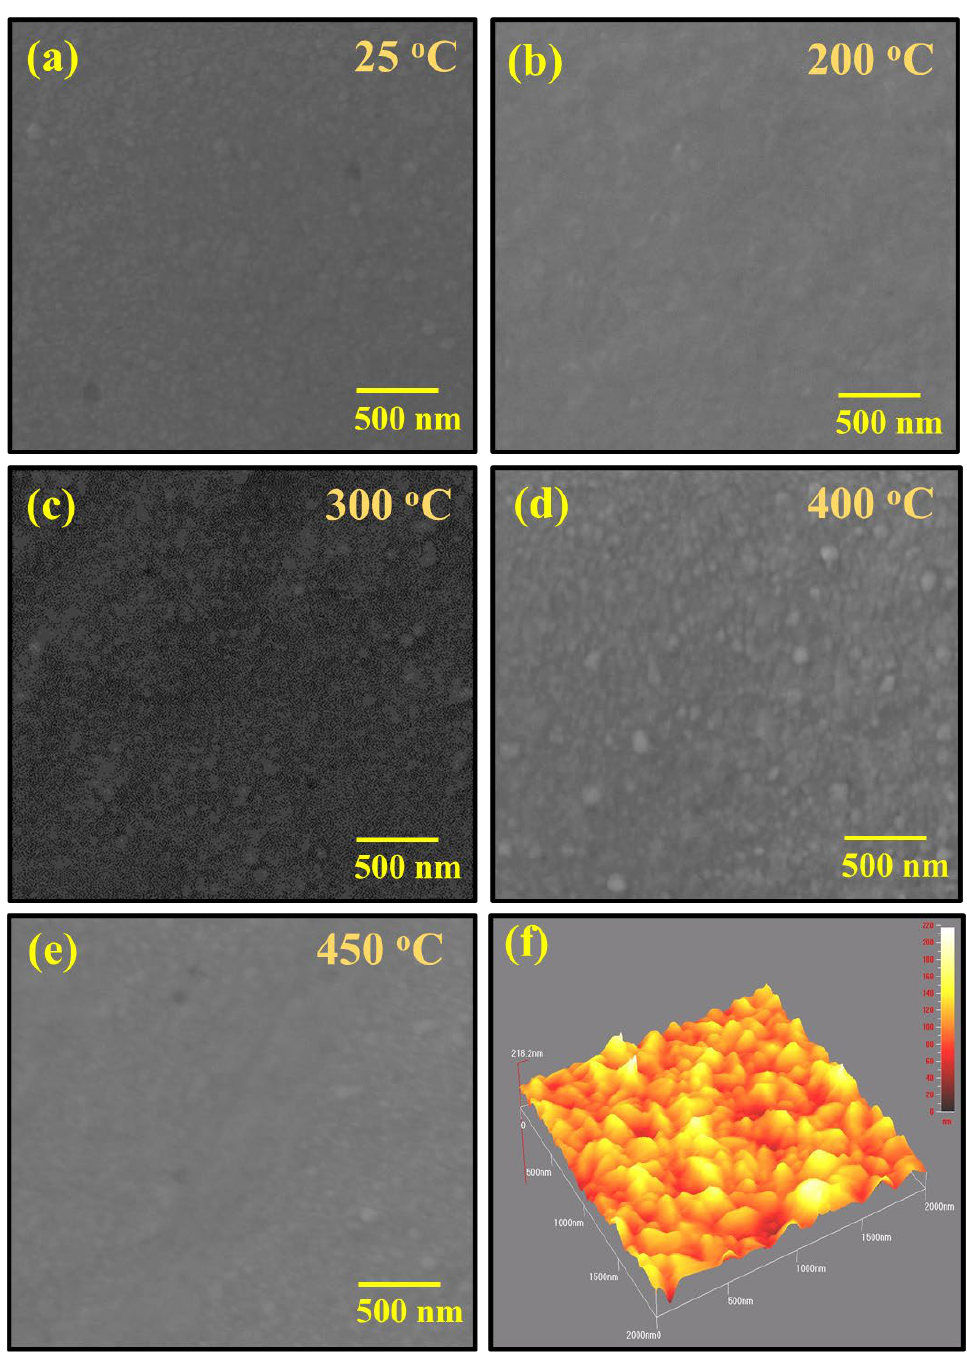
Figure 2. FESEM images of PbS thin film at ( a ) 25 °C, ( b ) 200 °C, ( c ) 300 °C, ( d ) 400 °C, and ( e ) 450 °C, along with the atomic force microscopy topography of as-deposited samples ( f